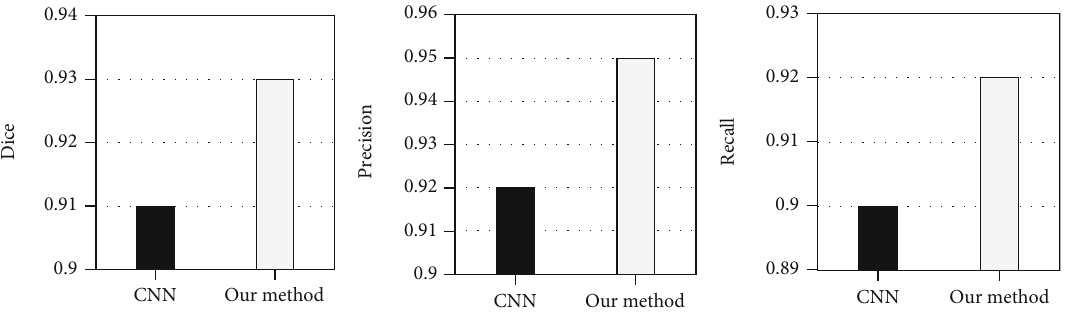
Figure 3: Quantitative indexes of segmentation e ff ect of cardiac abnormal